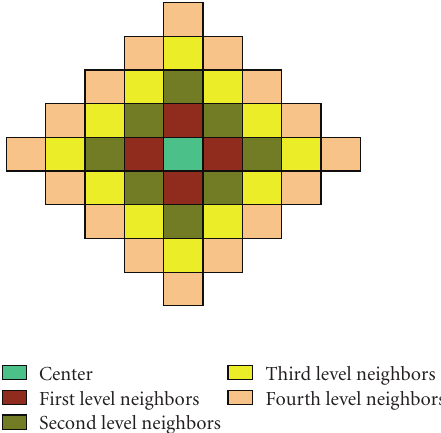
Figure 1: Schematic of adaptive multigrid grouping